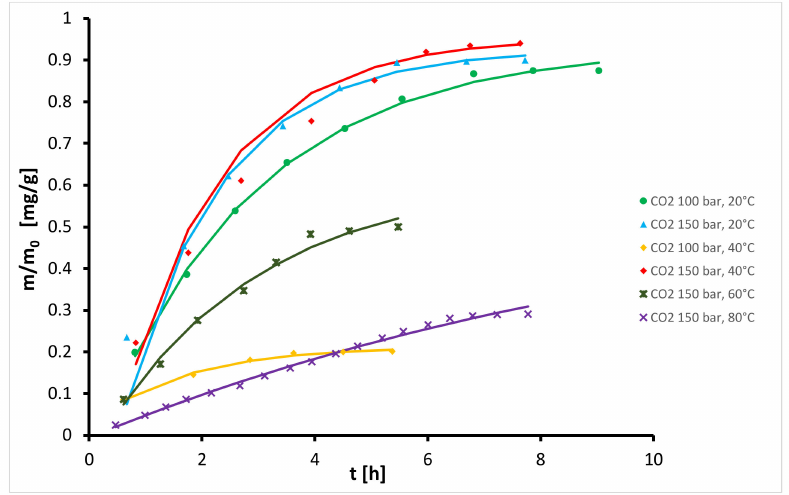
Figure 5. Experimental (symbols) and modelled (lines) kinetic curves for the extraction with CO 2 as